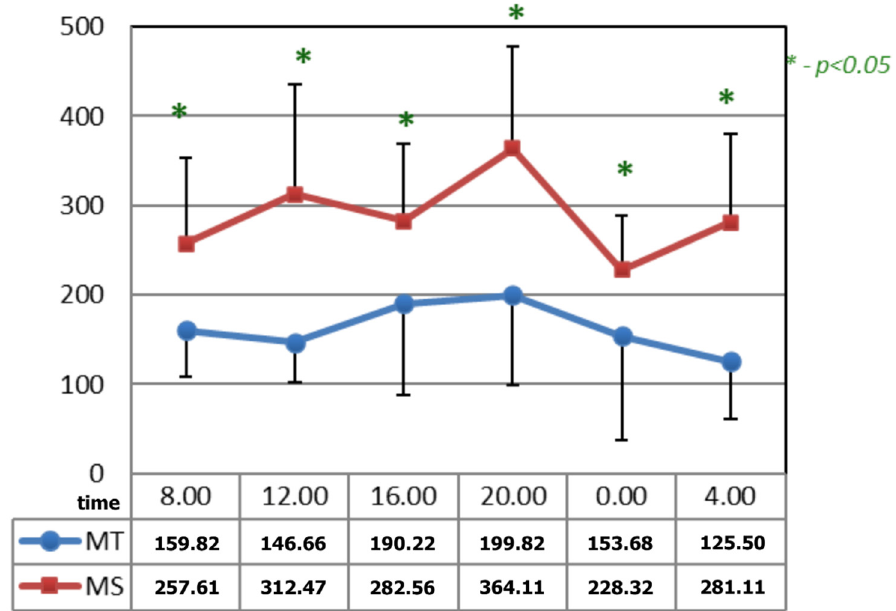
Figure 4. Comparison of the circadian concentration (ng/mL) of serotonin after 15 applications of magnetotherapy and magnetic stimulation. * statistical significance.